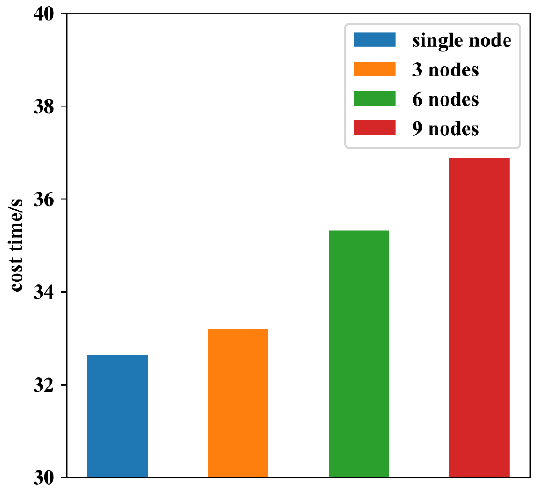
Figure 16. Impact of the number of blockchain nodes on the processing speed of an individual node.